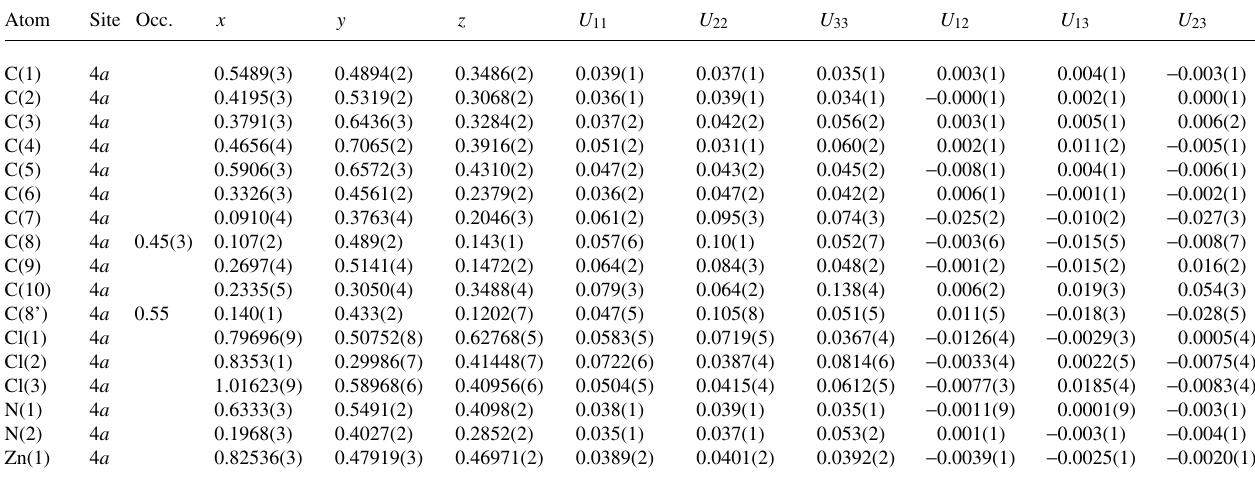
Table 3. Atomic coordinates and displacement parameters (in Å 2 ) .